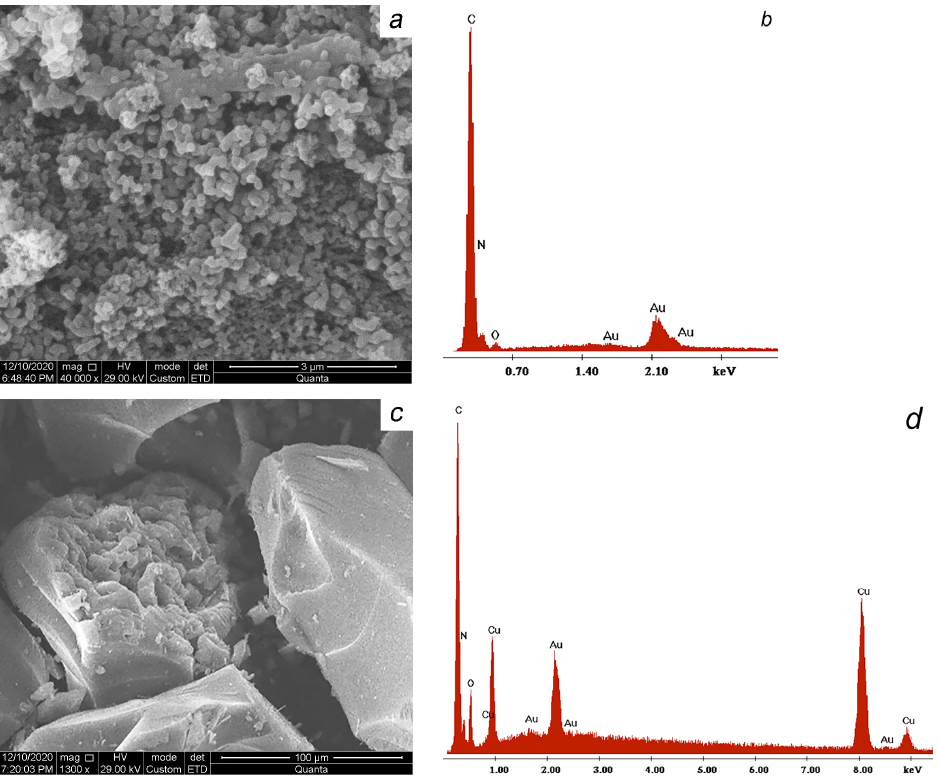
Figure 9. SEM ( a , c ) and EDS ( b , d ) of PVI ( a , b ) and nanocomposite 4 ( c , d ). The resistance of PVI and nanocomposites to thermal oxidative destruction was studied by TGA and DSC methods. According to thermogravimetric analysis, the thermal stability of the initial poly-N-vinylimidazole is 380 °C (Figure 10a). Complete combustion of PVI occurs at 530 °C.